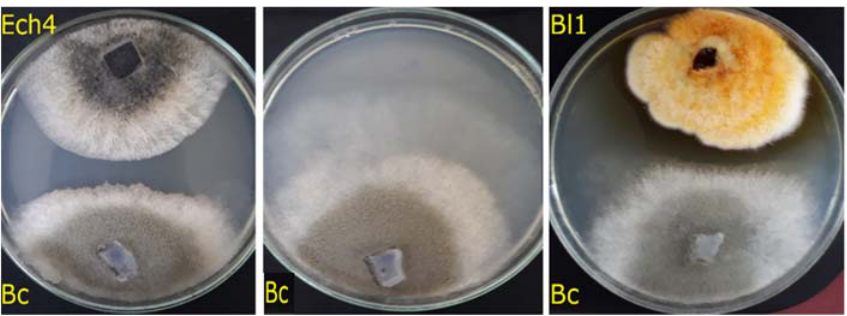
Figure 3. Effect of the isolates Ech4 ( upper left ) negative control ( center ) and Bl1 ( upper right ) on the mycelial growth of B. cinerea ( bottom of both pictures).